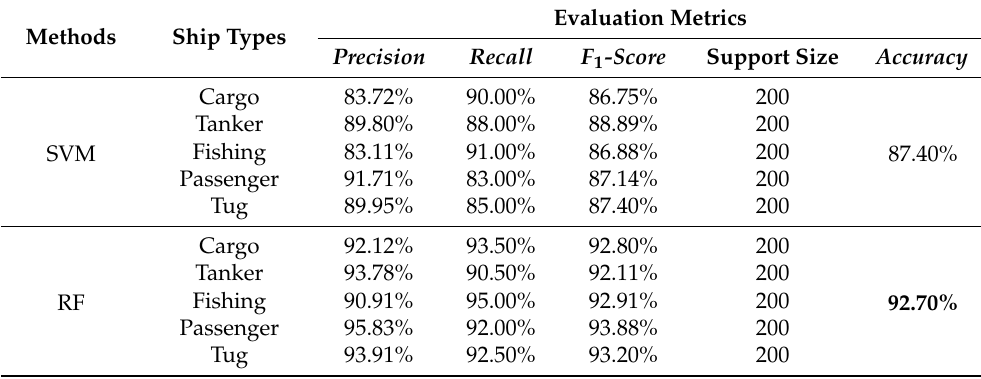
Table 6. The classification results of the five types of ships by considering both the geometric features and behavior